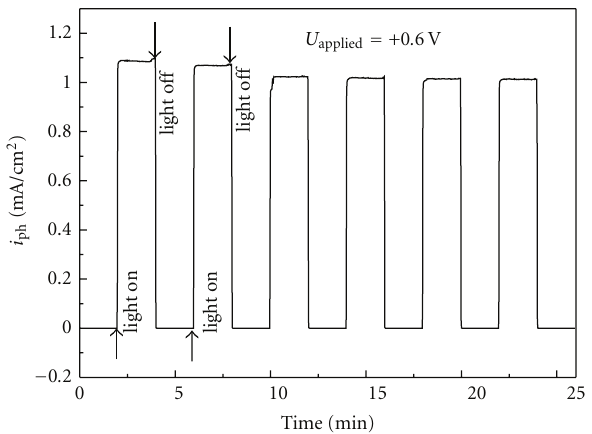
Figure 5: Photocurrent densities versus time of TiO 2 nanotubes array being applied with 0.6 V bias potential (versus SCE) under simulated solar light illumination. A 0.1MNaCl solution was used as the electrolyte.